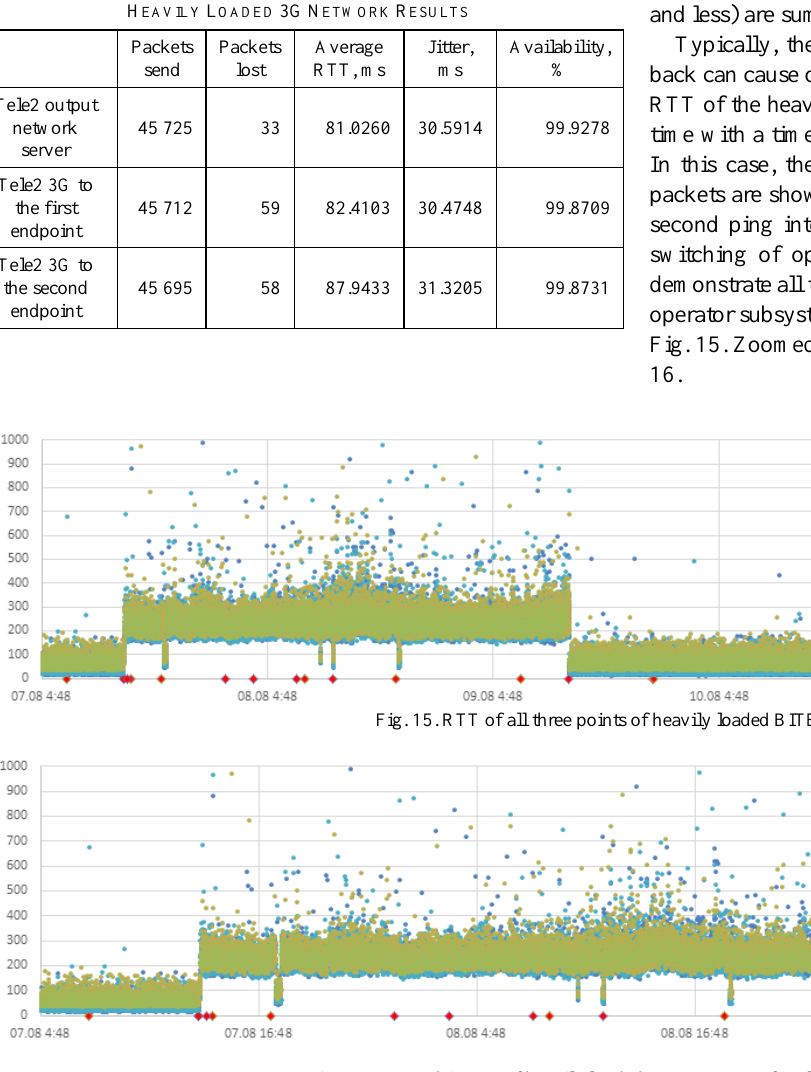
Fig. 16. Zoomed-in part of heavily loaded BITE 3G RTT for all three points, ms